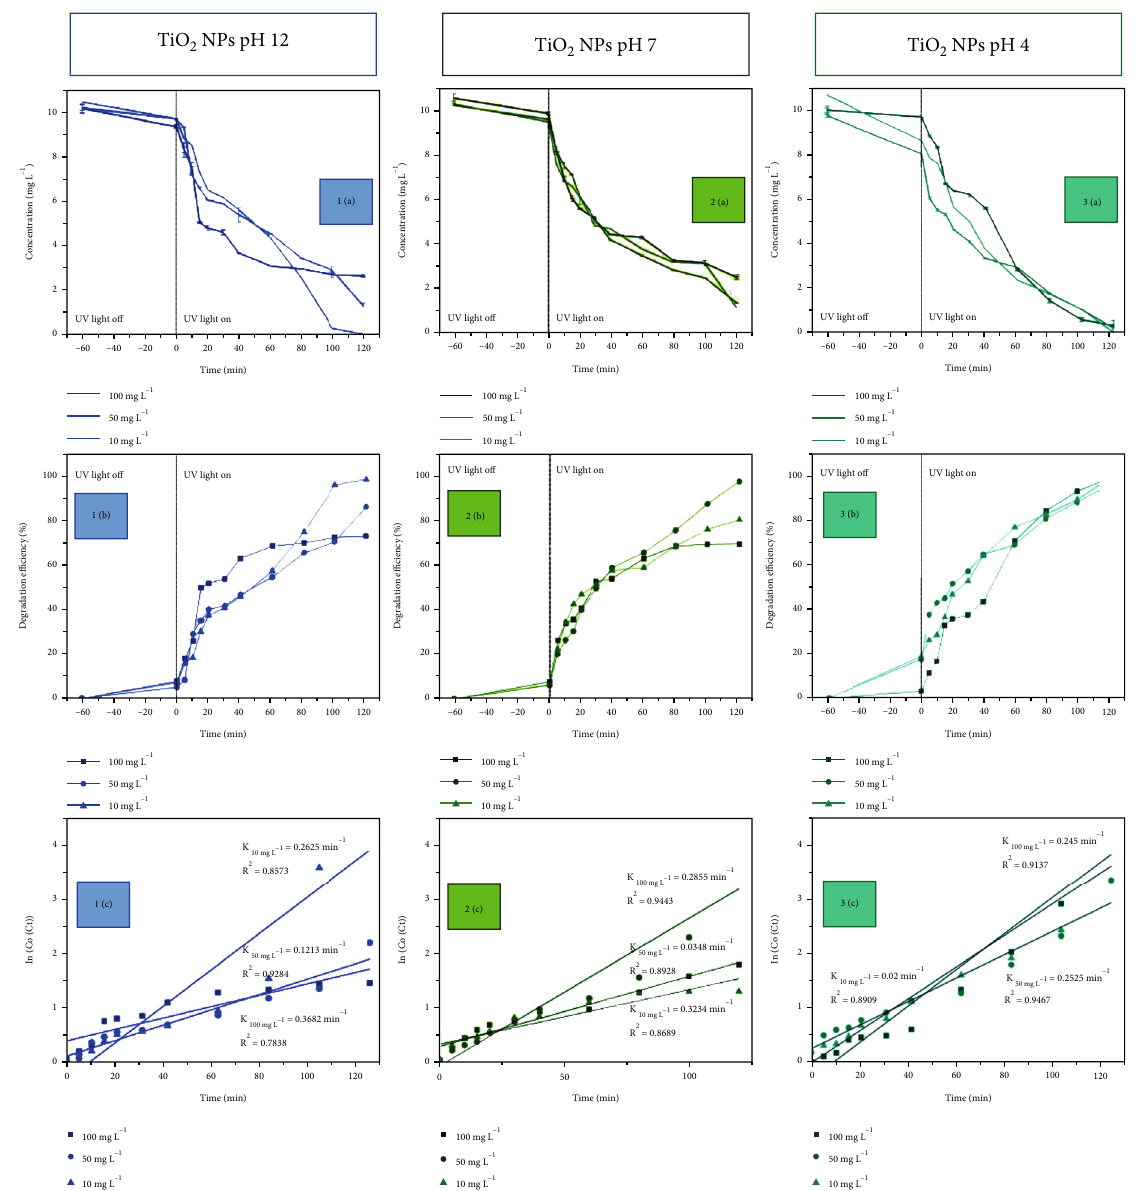
Figure 4: Phenol concentration for TiO 4 (3b), and the Langmuir-Hinshelwood kinetics model for TiO